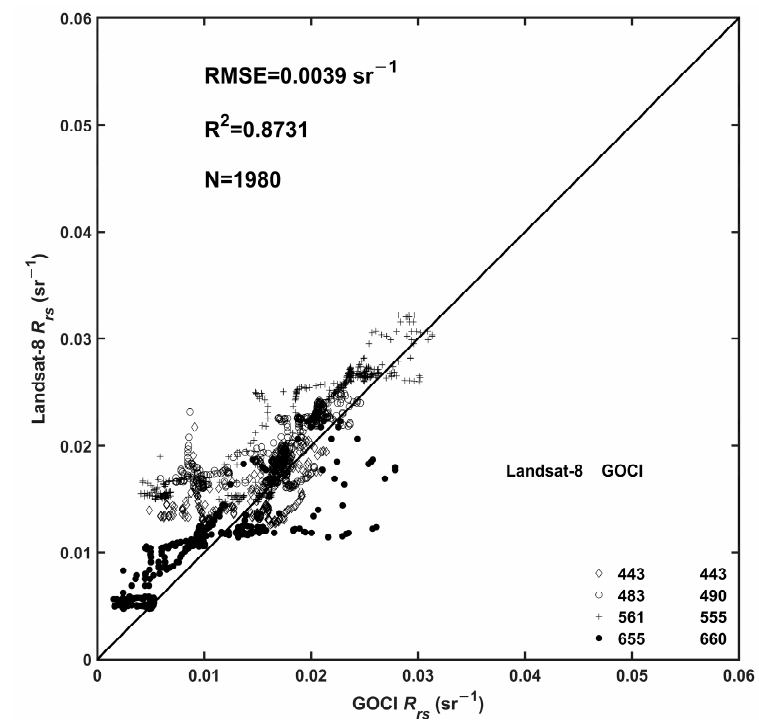
Figure 6. GOCI-retrieved R rs versus L8/OLI measurements.